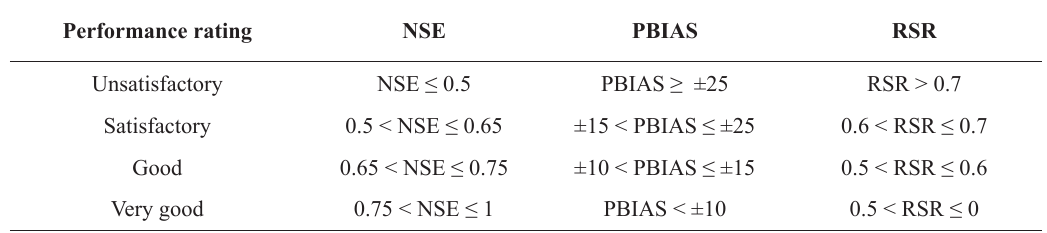
Table 1: Performance ratings for HEC HMS according to the (Ang and Oeurng, 2018; Moriasi et al .,